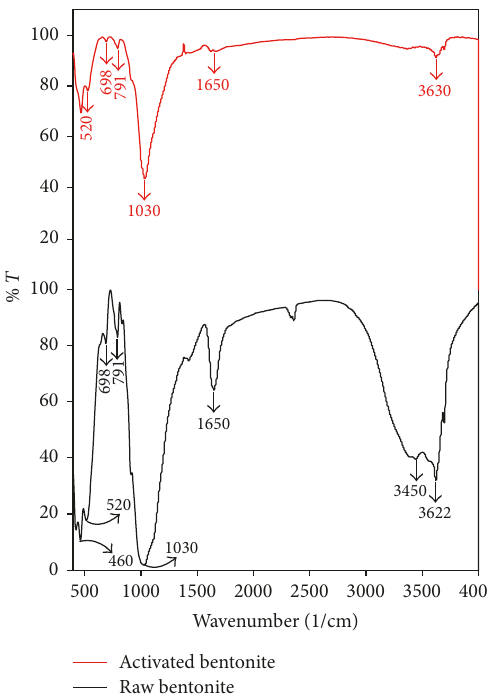
Figure 1: FTIR spectra of raw and acid activated Jordanian ben-